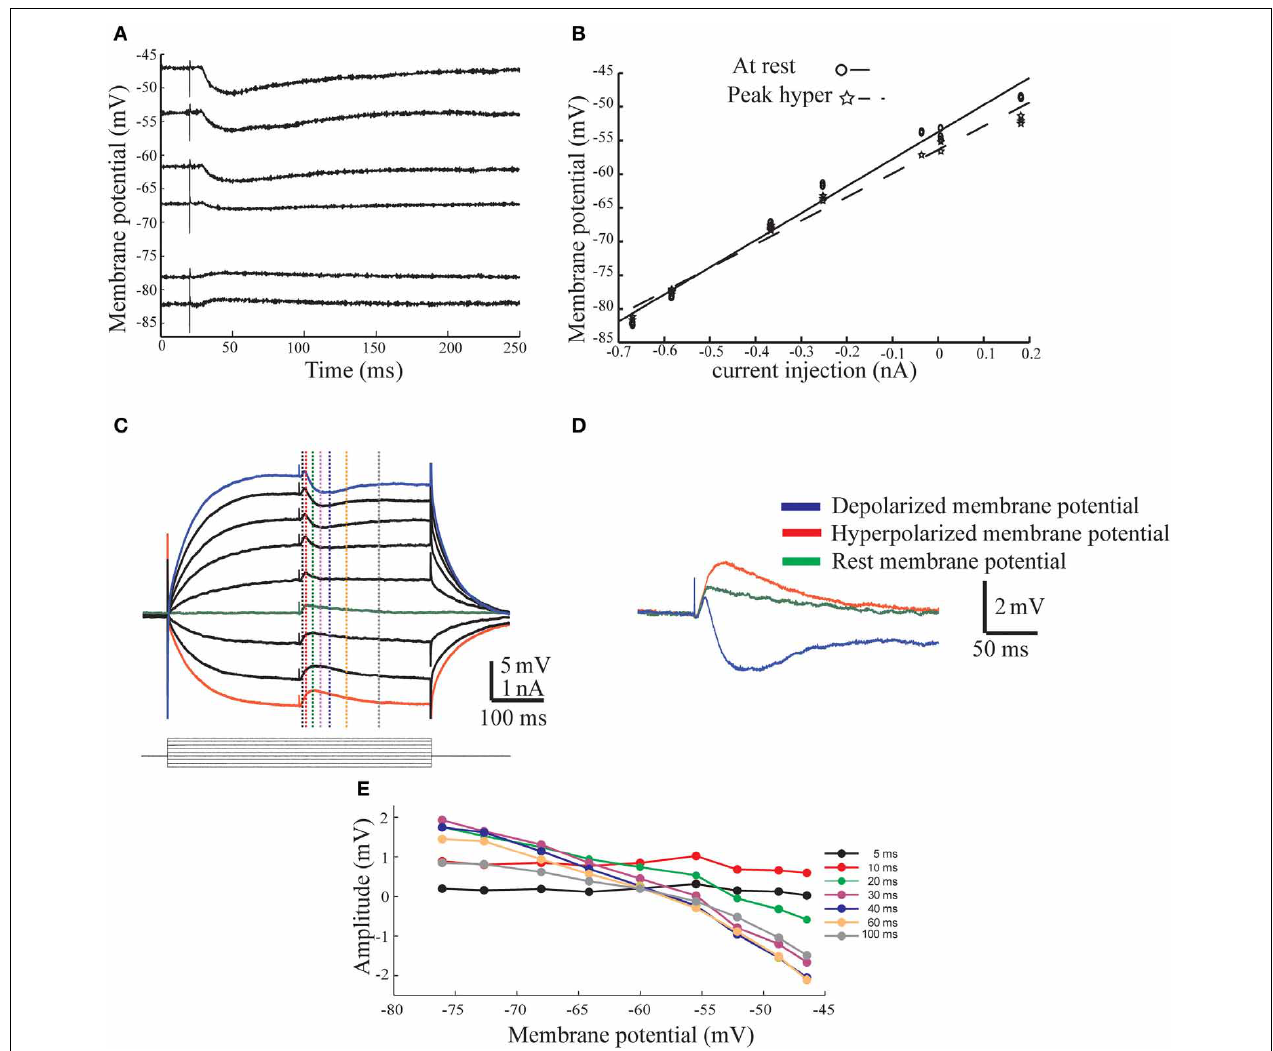
FIGURE 2 | The conductance base of the response evoked by afferent nerve stimulation. (A) Inhibitory response evoked by afferent nerve stimulation from different levels of membrane potential. Note a clear reversal of the response. (B) The current voltage relationship measured at the peak of the response (dashed line) and before the stimulus onset (continues line). (C) Excitatory response evoked by afferent nerve stimulation from different levels of membrane potential Note the